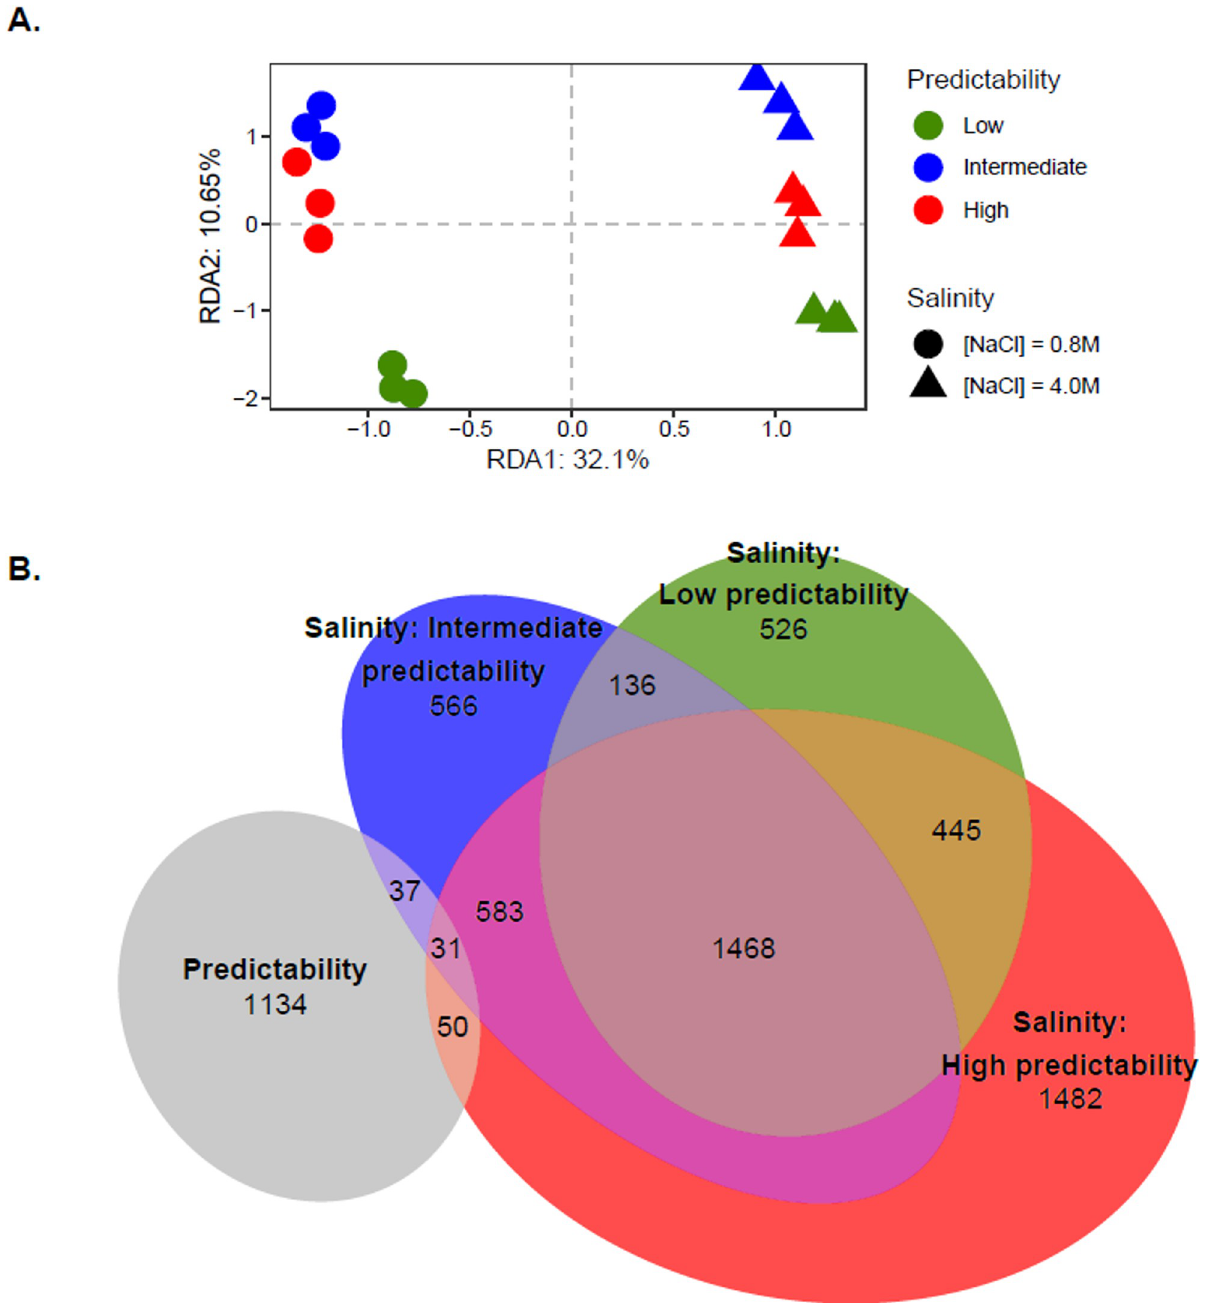
Fig 3. Evolution and plasticity of gene expression. (A) Variation of gene expression levels across evolved populations. RDA plot performed on gene expression levels according to evolution conditions (colors) and salinity during plasticity assay (shapes). ( B) Distribution of DE transcripts. Venn diagram describing the numbers of DE transcripts across evolutionary conditions (Predictability, light gray) identified by performing LRT (FDR < 0.05) as implemented in DESeq2 , and between salinities (Wald test, FDR < 0.05 after BH adjustment and |log 2 FC| > 1) for 3 evolutionary conditions: low (green), intermediate (blue), and high (red) predictability of environmental changes. The raw data underlying this figure are available in the Figshare repository https://doi.org/10.6084/m9.figshare.21905670. DE, differentially expressed; LRT, likelihood-ratio test; RDA, redundancy